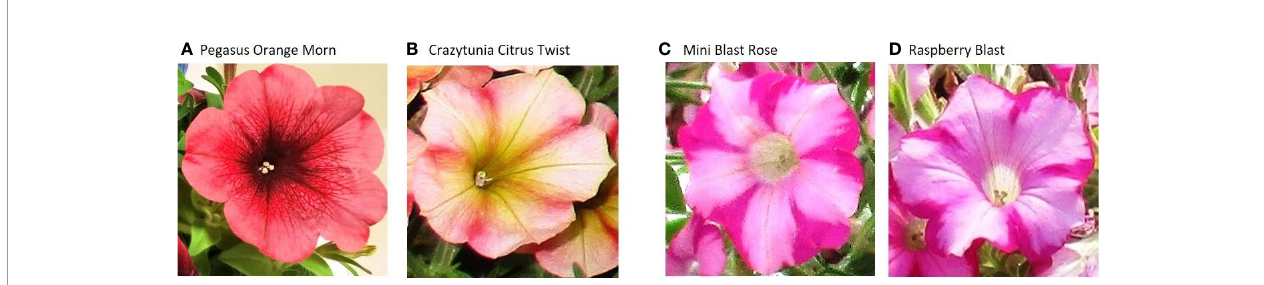
FIGURE 1 | Photographs of individual petunia fl owers representing G1 varieties (A, B) and G2 varieties (C, D)